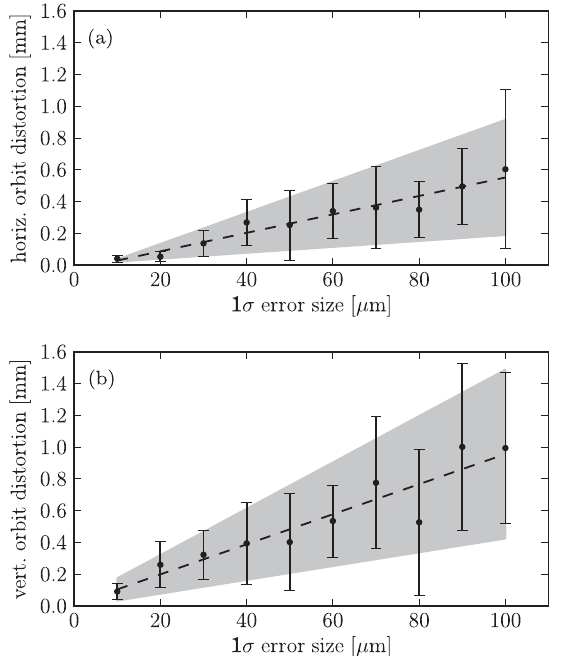
FIG. 7. Orbit distortion as a result of introducing horizontal and vertical alignment errors to the proton ring. The black points correspond to the mean of the ten runs at each (cid:6) value and error bars correspond to the rms spread of the ten runs. The shaded region is the area between the maximum and minimum linear fit, where the central linear fit determines the amplification factor in each case. (a) Fitted distribution of horizontal alignment errors. (b) Fitted distribution of vertical alignment